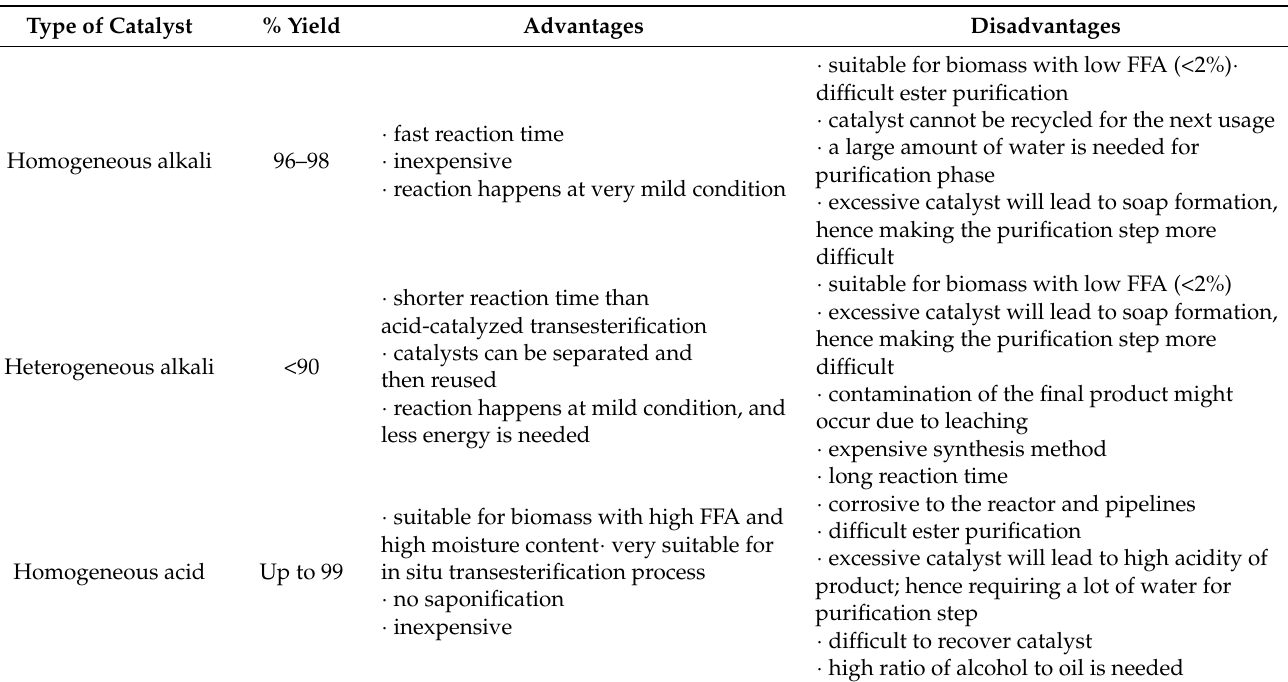
Table 6. Comparisons on the characteristics of conventional in situ transesterifications using different types of catalysts (adapted from